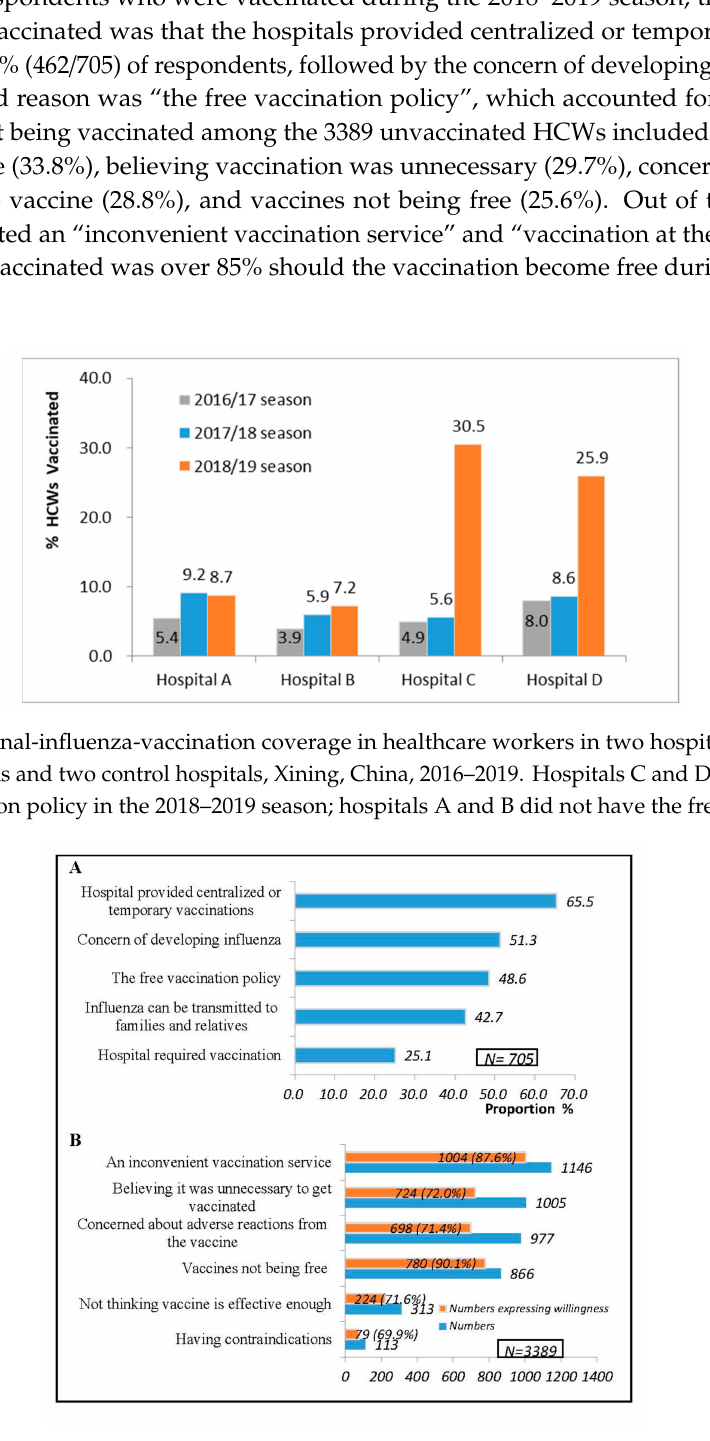
Figure 2. Reasons for receiving and not receiving the influenza vaccination and willingness to be vaccinated among healthcare workers during the 2019–2020 season. Panel A : Reasons for being vaccinated and response rate; Panel B : Reasons for not being vaccinated and willingness to be vaccinated if vaccination became free in the hospital during the 2019–2020